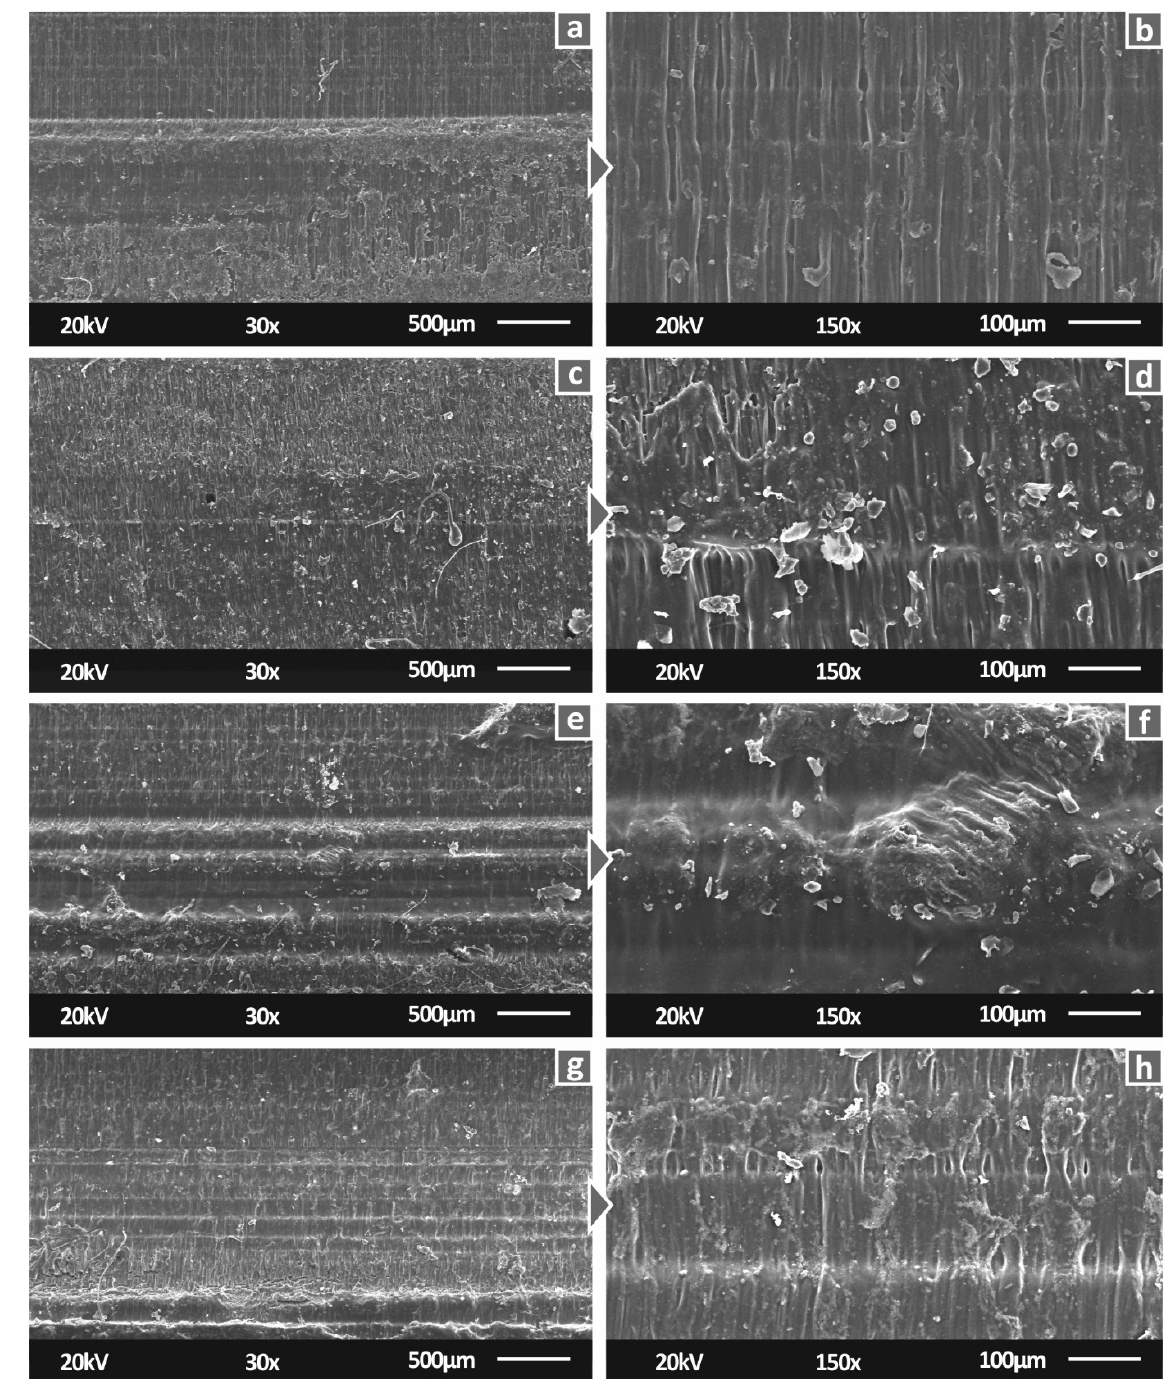
Figure 8. Side surface of tensile specimens in 30× magnification for ( a ) Pure SC, ( c ) SC Cu 0.5 wt.%, ( e ) SC Cu 1.0 wt.%, ( g ) SC Cu 2.0 wt.%, same surfaces in 150× magnification for ( b ) Pure SC, ( d ) SC Cu 0.5 wt.%, ( f ) SC Cu 1.0 wt.%, ( h ) SC Cu 2.0 wt.%.